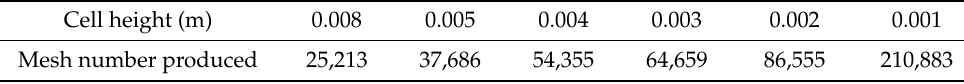
Table 1. The number of meshes produced for different cell